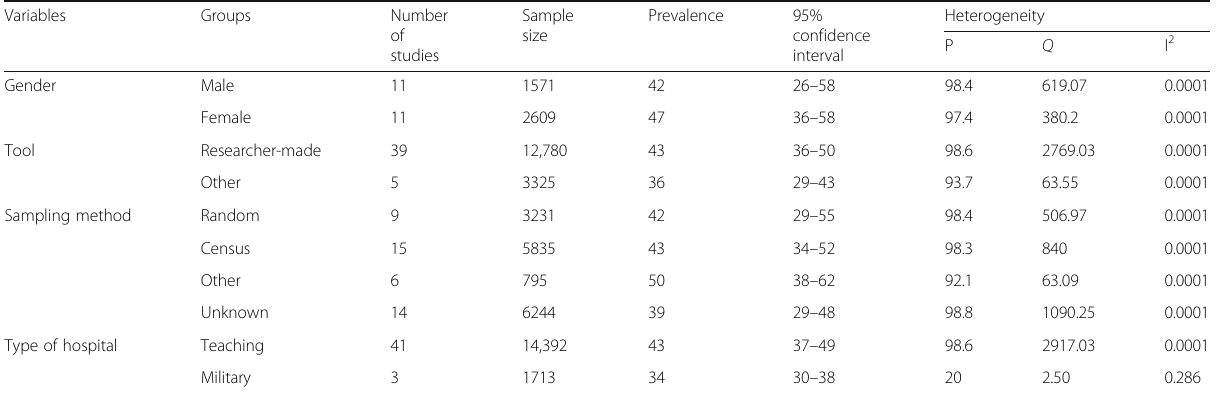
Table 2 Prevalence of needlestick injuries in each subgroup Variables